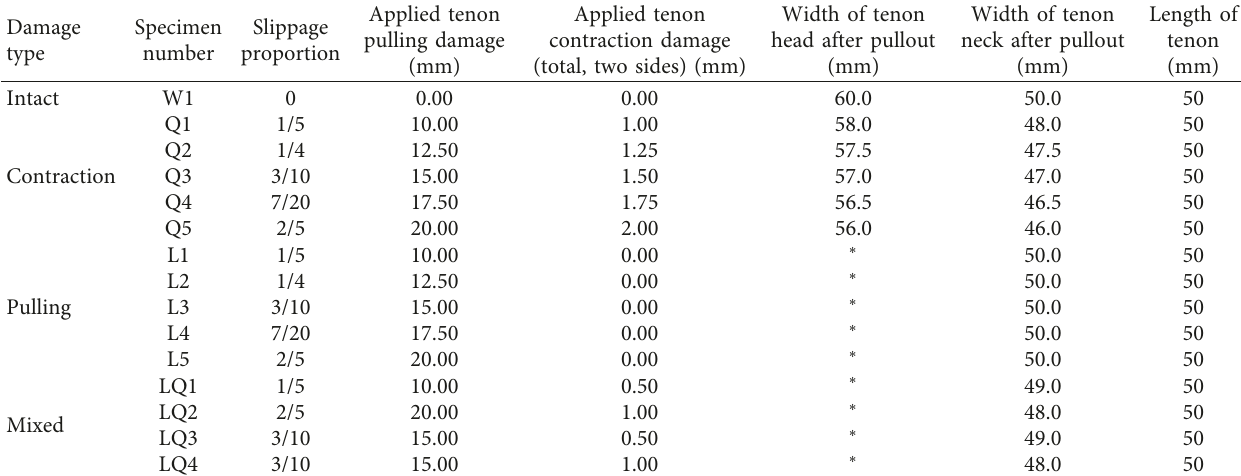
Table 2: Simulation parameters for different tenon sizes and pulling levels.